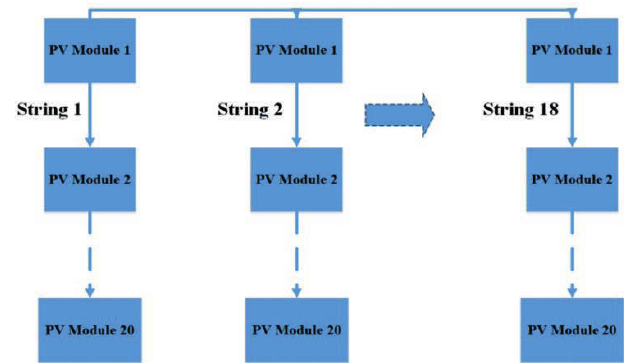
Fig. 2. The layout of one combine box of QASP.